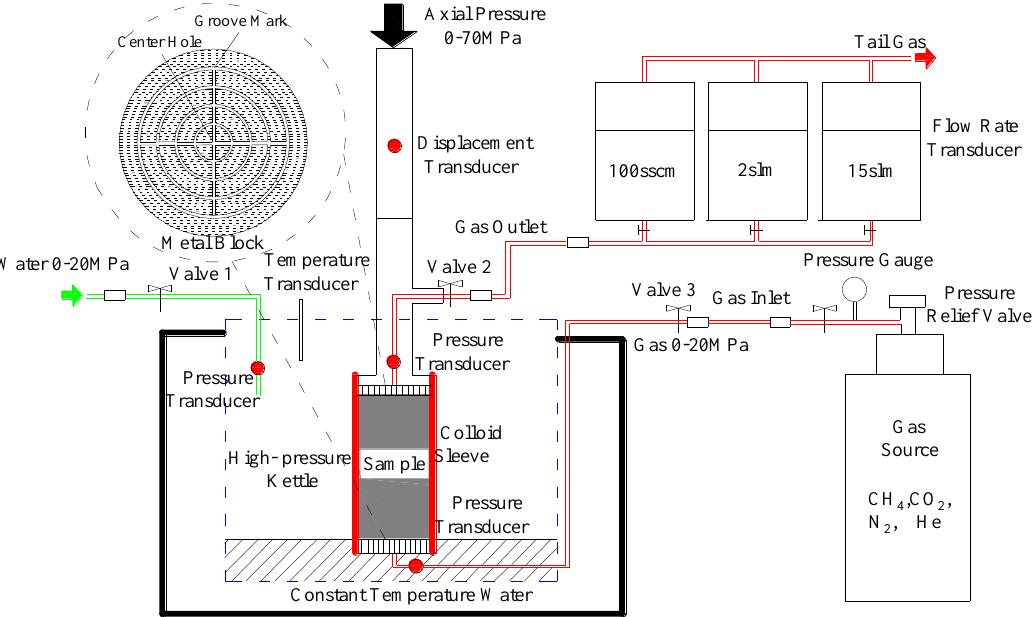
Figure 2. Schematic diagram of the seepage test system for damaged coal-rock masses. Appl. Sci. 2018 , 8 , x FOR PEER REVIEW